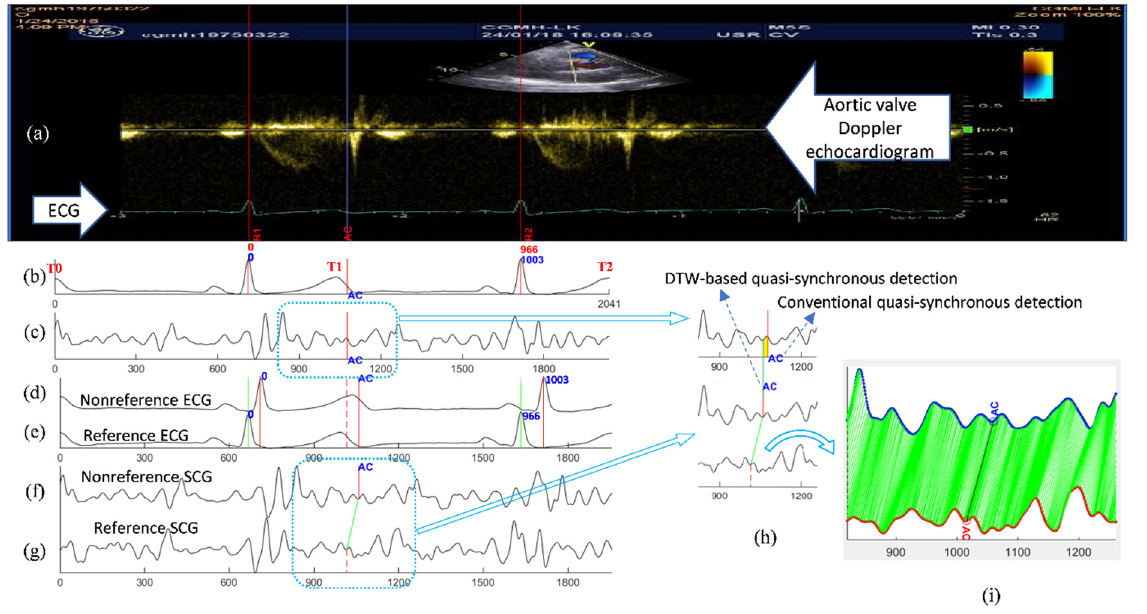
Figure 7. Illustrations and comparison of the fiducial point detection in the nonreference SCG signal between the methods of the conventional and the DTW-based quasi-synchronous alignment: ( a ) Doppler echocardiogram image with the identified ECG R peaks (R1, R2) and aortic valve closing